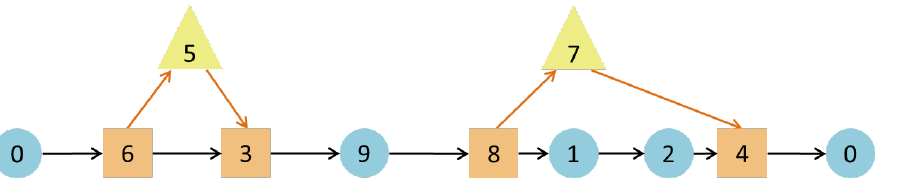
Figure 2. The structure of a principal–assistant route r : The principal agent serves circle and square vertices. The assistant agent serves triangle vertices. The principal agent releases or retrieves the assistant agent at square